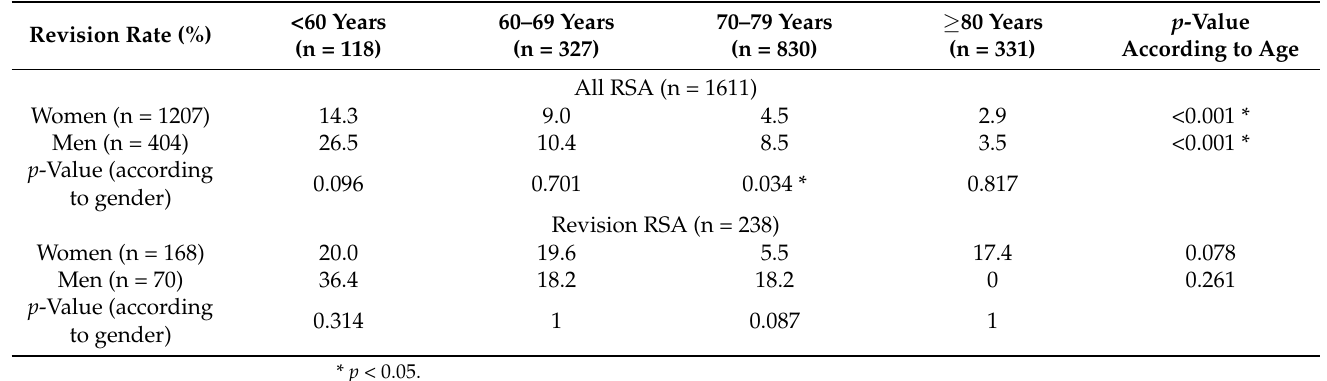
Table 5. Revision rate according to age stratified by gender.